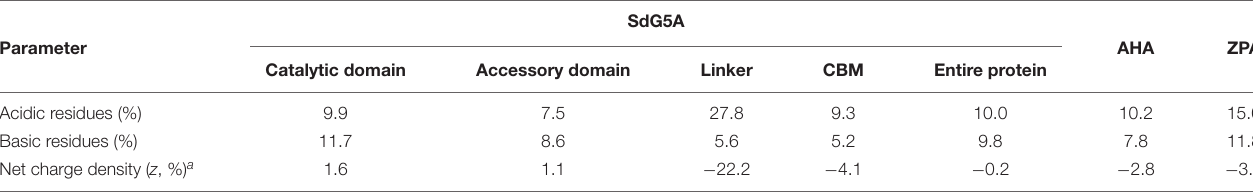
TABLE 2 | Comparison of the frequencies of charged amino acid residues for different domains in SdG5A and other extremophilic